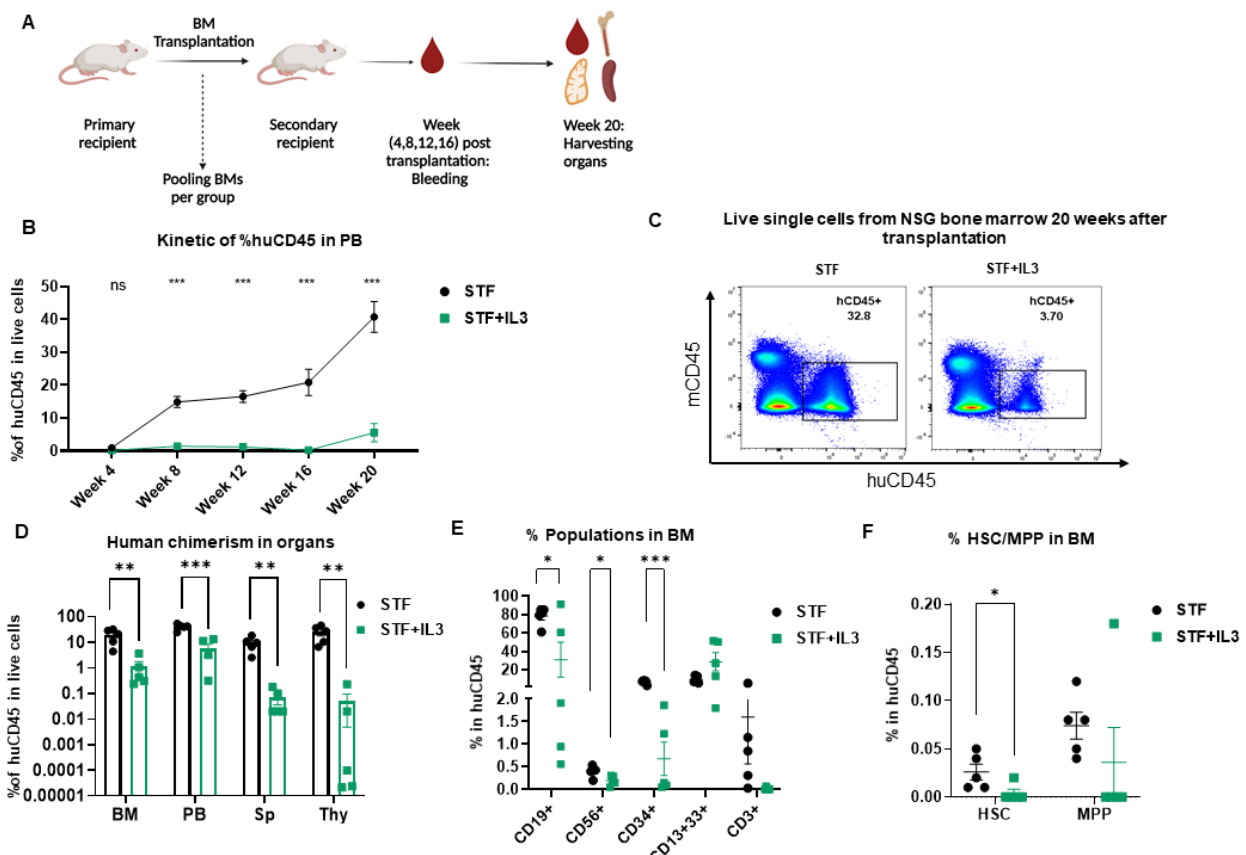
Figure 3. Negative effect of IL3 on repopulating capacity of hematopoietic stem cells revealed by secondary transplantation: ( A ) Schematic picture of secondary transplantation. ( B ) Human engraft-